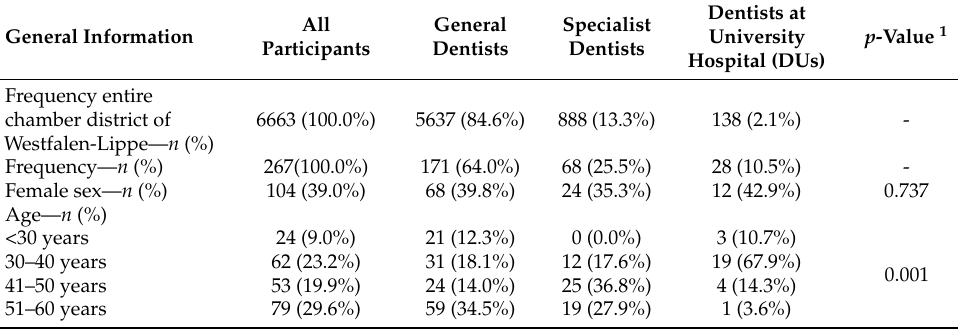
Table 1. General information about the